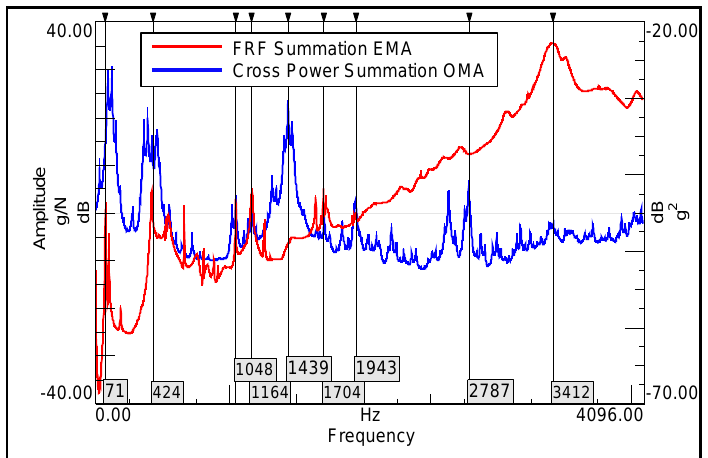
Figure 4. FRF summation from EMA and cross power summation from OMA.